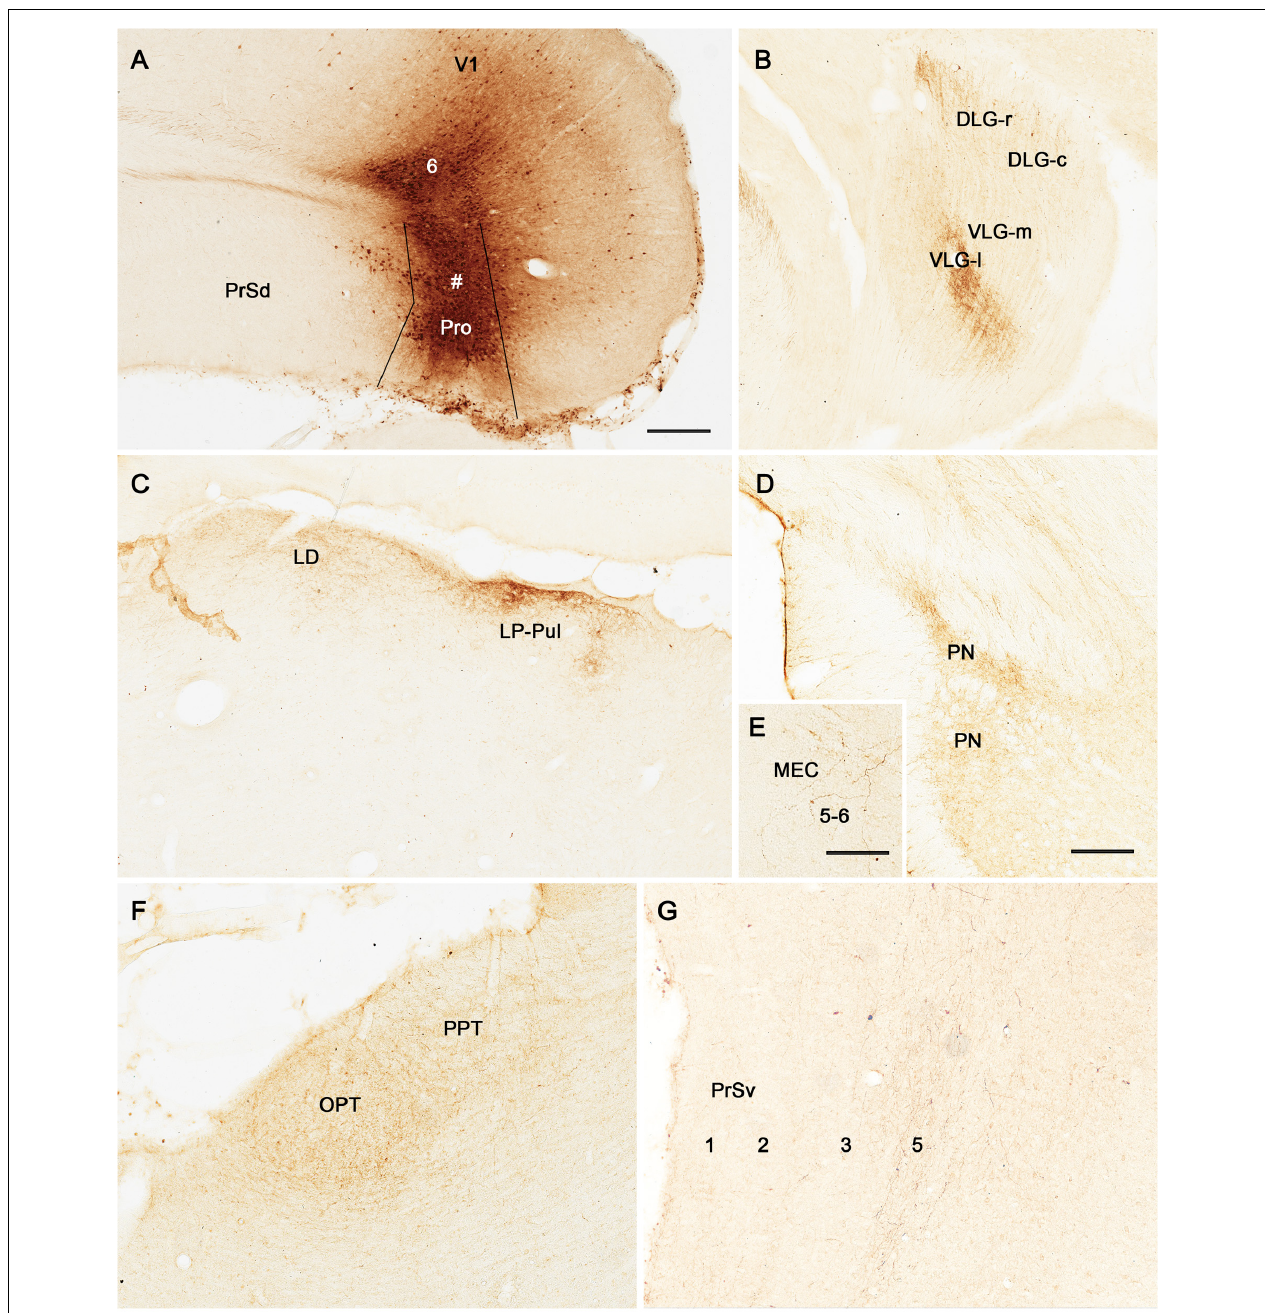
FIGURE 5 | Anterograde tracing following a biotinylated dextran amine (BDA) injection in rat prostriata. All panels are from sagittal sections. The BDA injection is mainly located in the prostriata (# Pro) with involvement in layer 6 of overlying V1 (A) . This injection predominantly results in anterograde labeling of axon terminals (B–G) . Labeled axon terminals are mainly distributed in the DLG-r (B) and lateral part of ventral lateral geniculate nucleus (VLG-l; B ), LD and LP-Pul (C) , lateral part of the pontine nucleus (PN in D ), layers 5–6 of medial entorhinal cortex (MEC) (E) , olivary and posterior pretectal nuclei (OPT and PPT in F ), and layer 5 of PrSv (G) . Bars: 300 µ m (A) for (A–C) ; 150 µ m (D) for (D,F) ; 100 µ m in (E) for (E,G) .